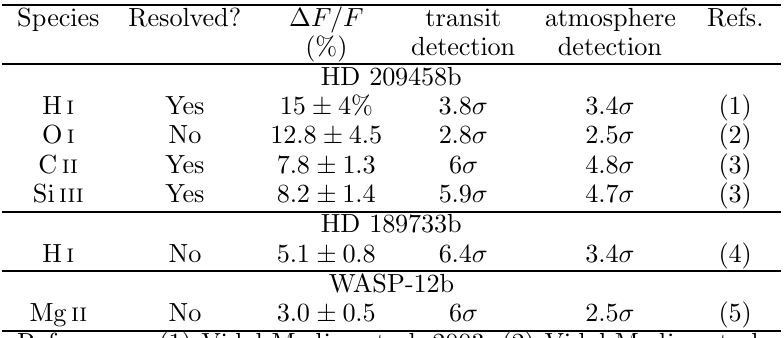
Table 1: Exoplanet atmospheric detections from UV